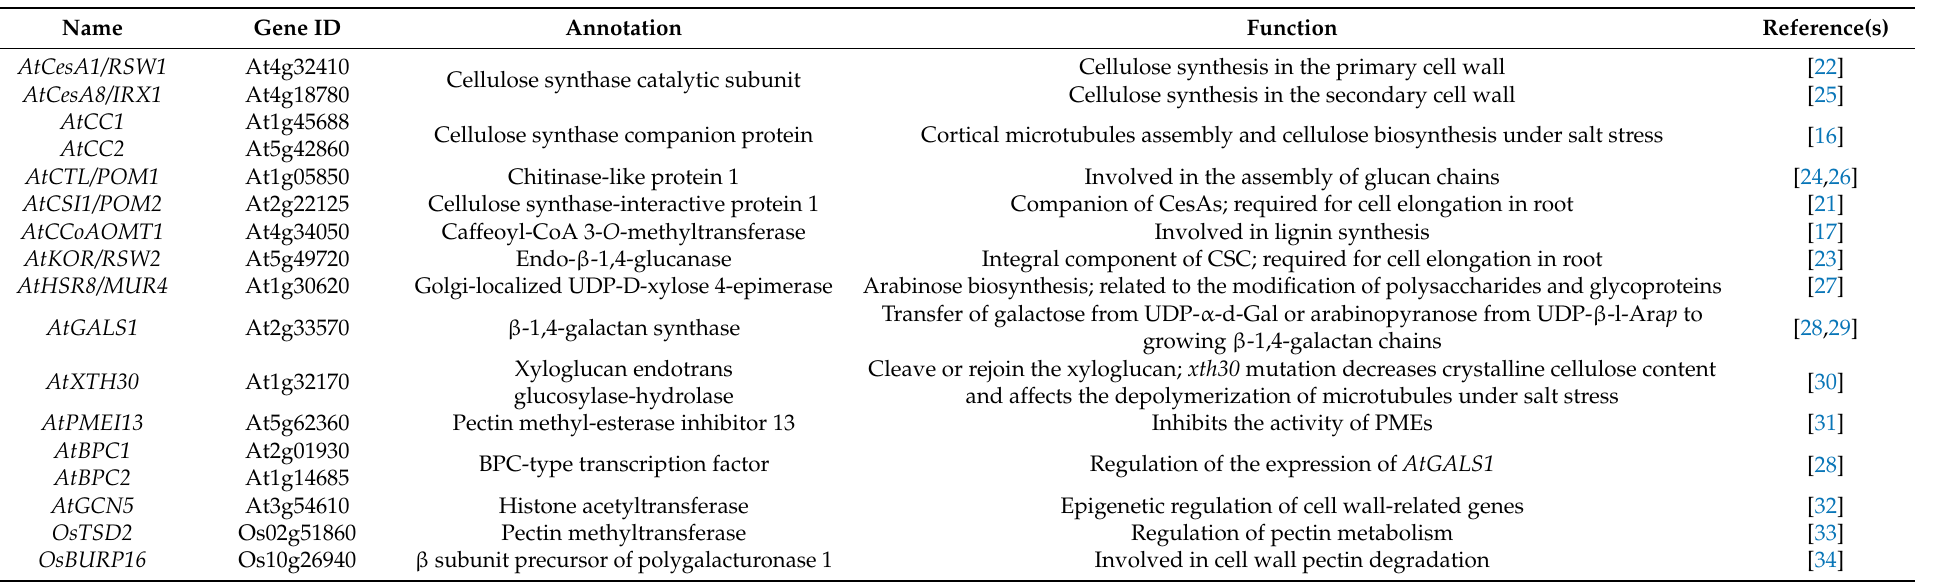
Table 1. List of the cell wall biosynthesis-related genes that are involved in salt stress